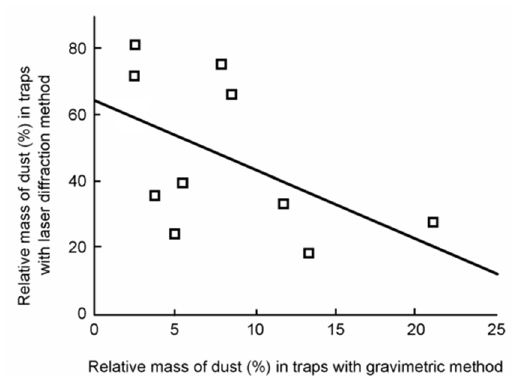
Figure 7. Scatter plot of the studied methods based on the concentration of PM in traps. The regression line is also indicated.